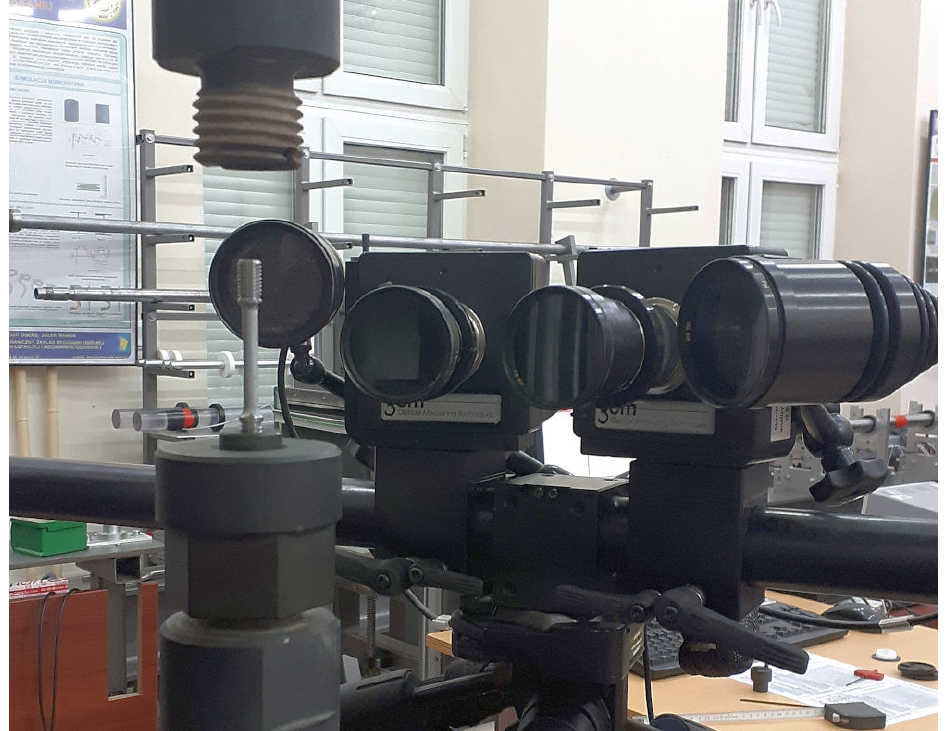
Figure 4. Installation of an exemplary specimen in a threaded holder of the Instron 8862 machine along with the setup of the 3D cameras of the DIC measurement system.